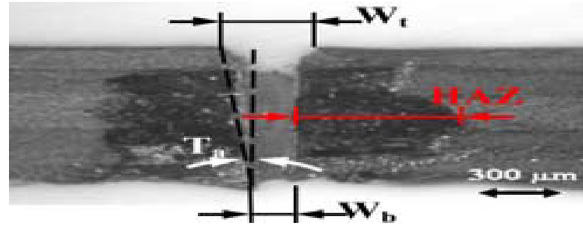
Fig. 5 Cut kerf geometry illustration [43]